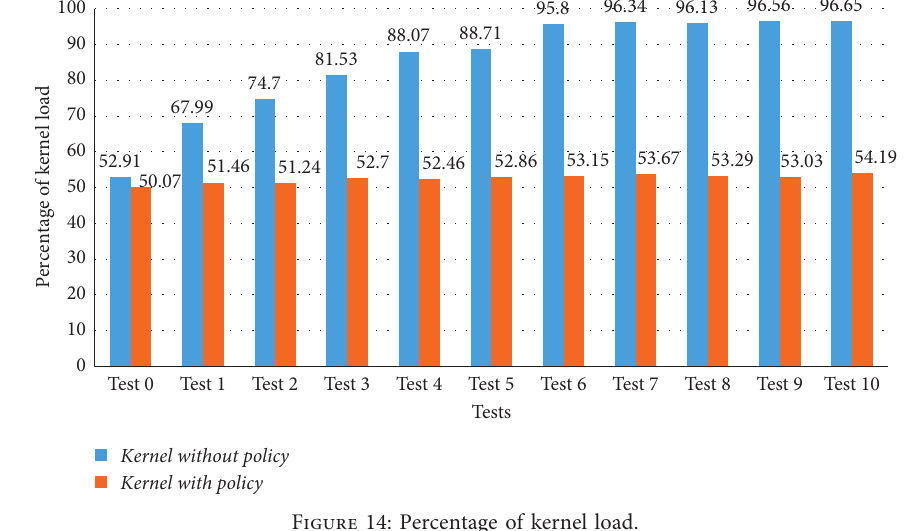
Figure 14: Percentage of kernel load.